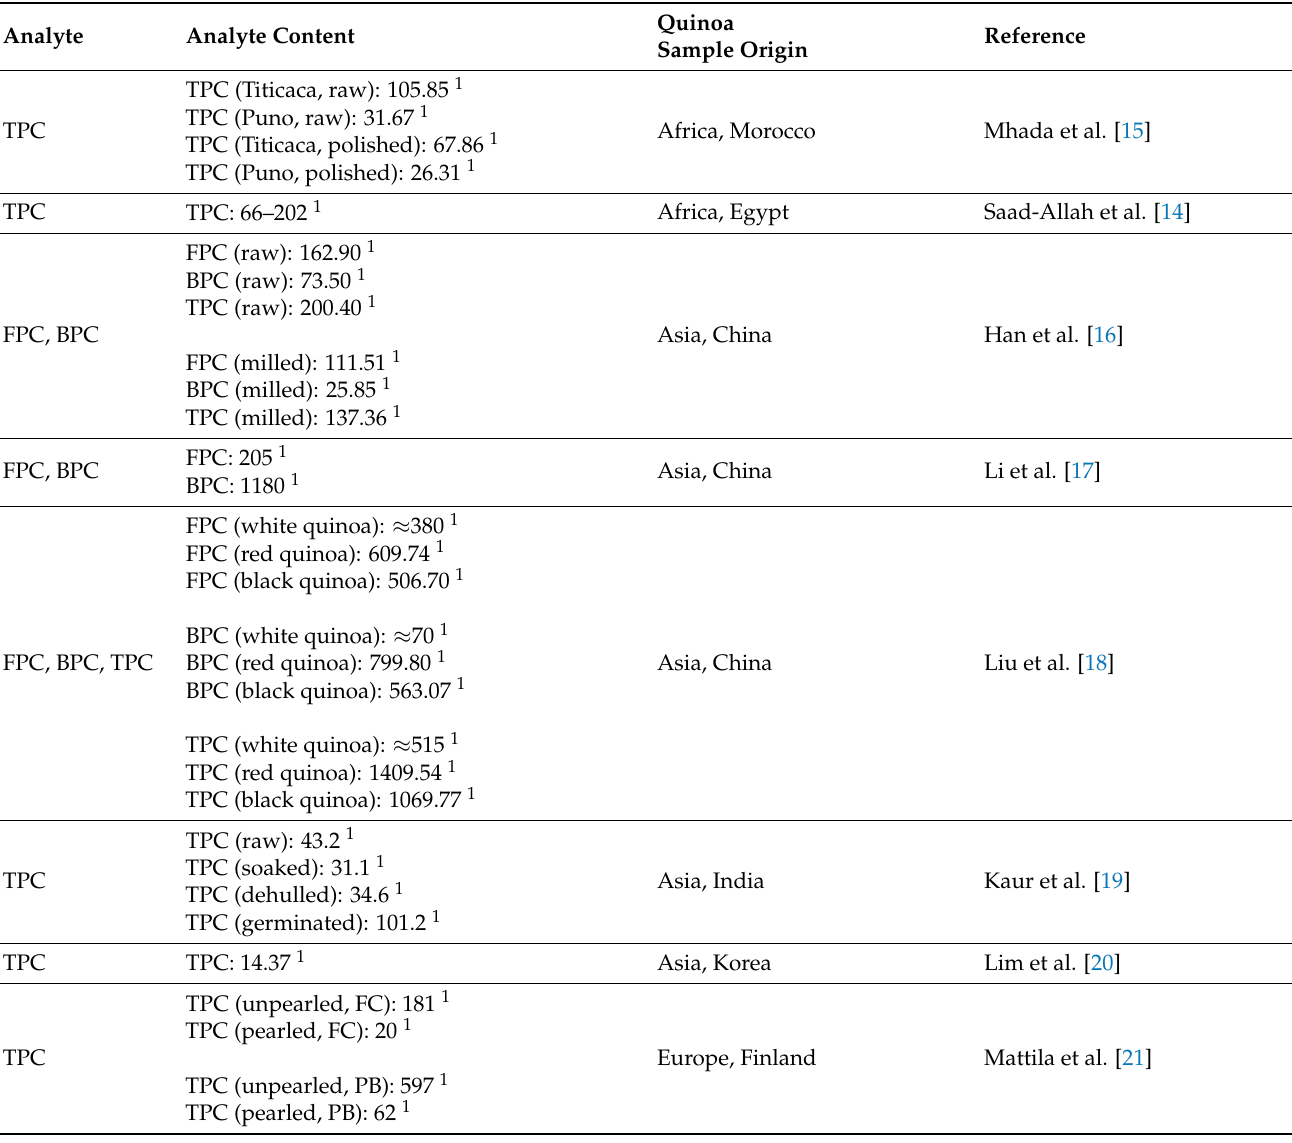
Table 2. Phenolic compounds in quinoa seeds quantified by spectrophotometric methods. Analyte Analyte Content